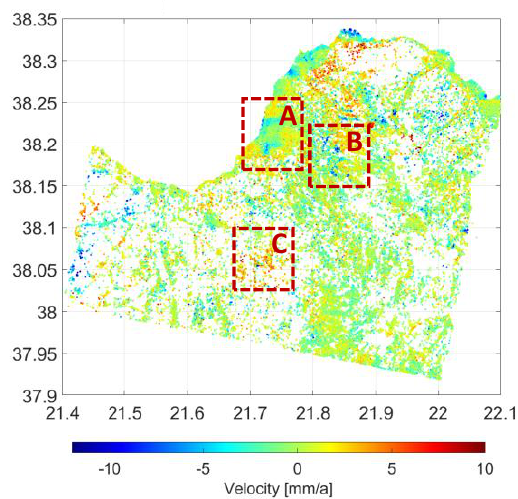
Figure 1. Mean veolocity map of Patars and the surroundig region for the time between January 2019 and January